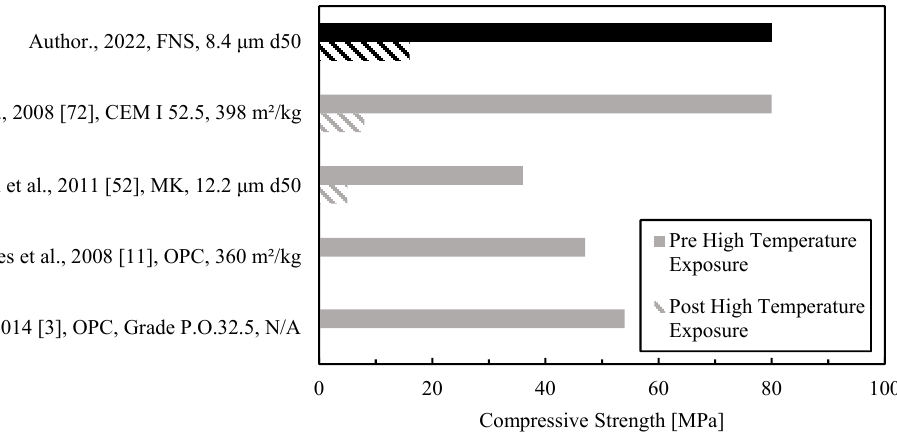
Figure 8. Compressive strength of low-calcium AAM pastes after exposure to a thermal load between 800 and 1000 °C.